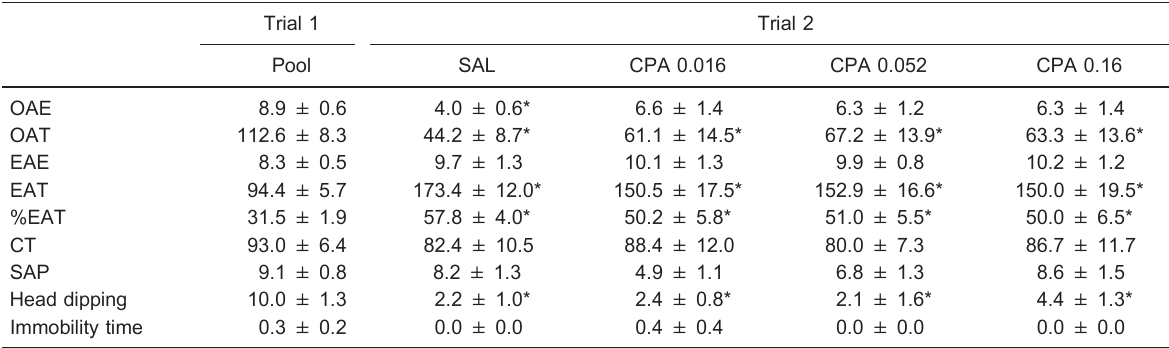
Table 2. Effects of H1 antagonist chlorpheniramine (CPA) microinjected into the cerebellar vermis on the behavior of mice in Trials 1 and 2 in the elevated plus maze